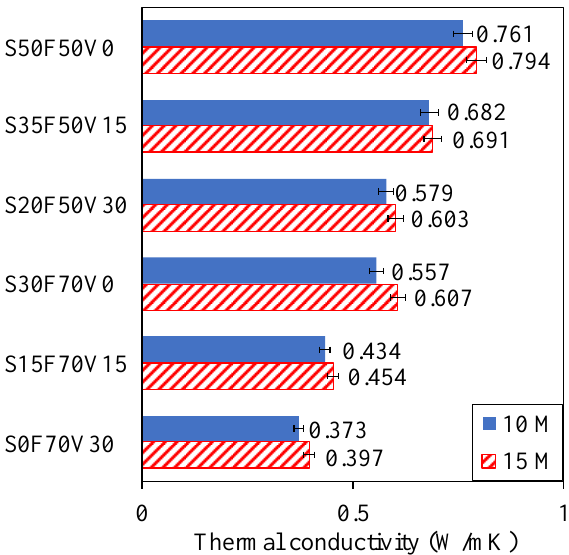
Figure 11. Thermal conductivities of the geopolymer mortar.